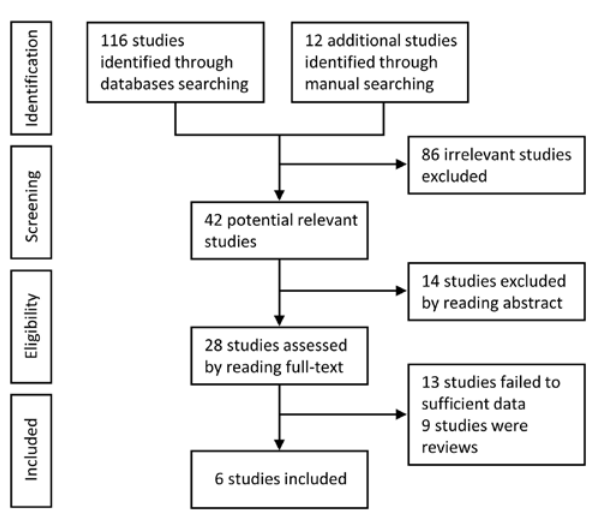
Figure 1: The flow chart of study selection.